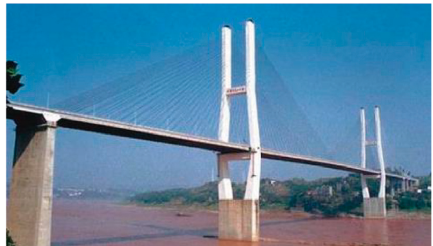
Figure 1: In situ photo of cable-stayed bridge studied in the